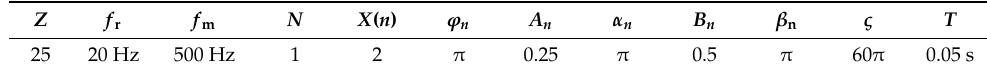
Table 1. Parameters of the simulation signal